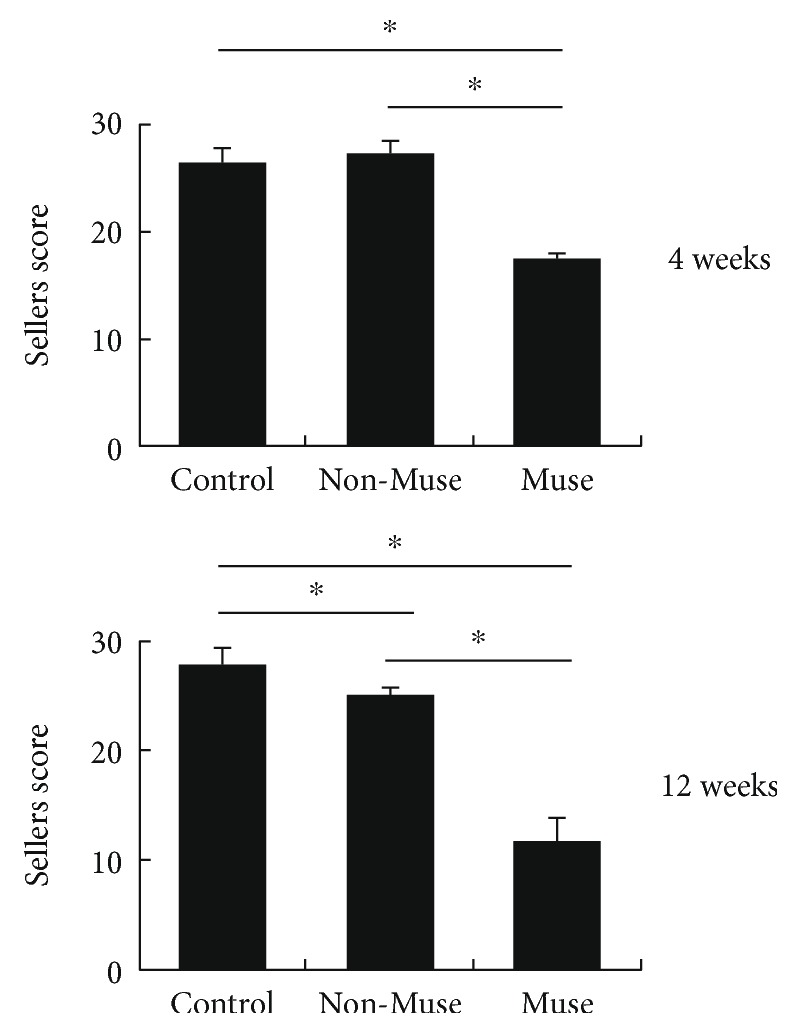
Histological scoring using Sellers scale at 4 and 12 weeks, with histologically significant difference in the Muse groups, unlike in either the non-Muse or control groups. ∗P < 0.05.